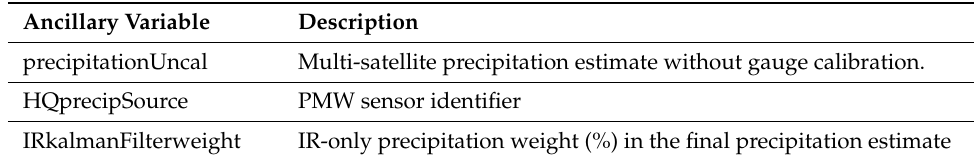
Table 3. IMERG ancillary variables and